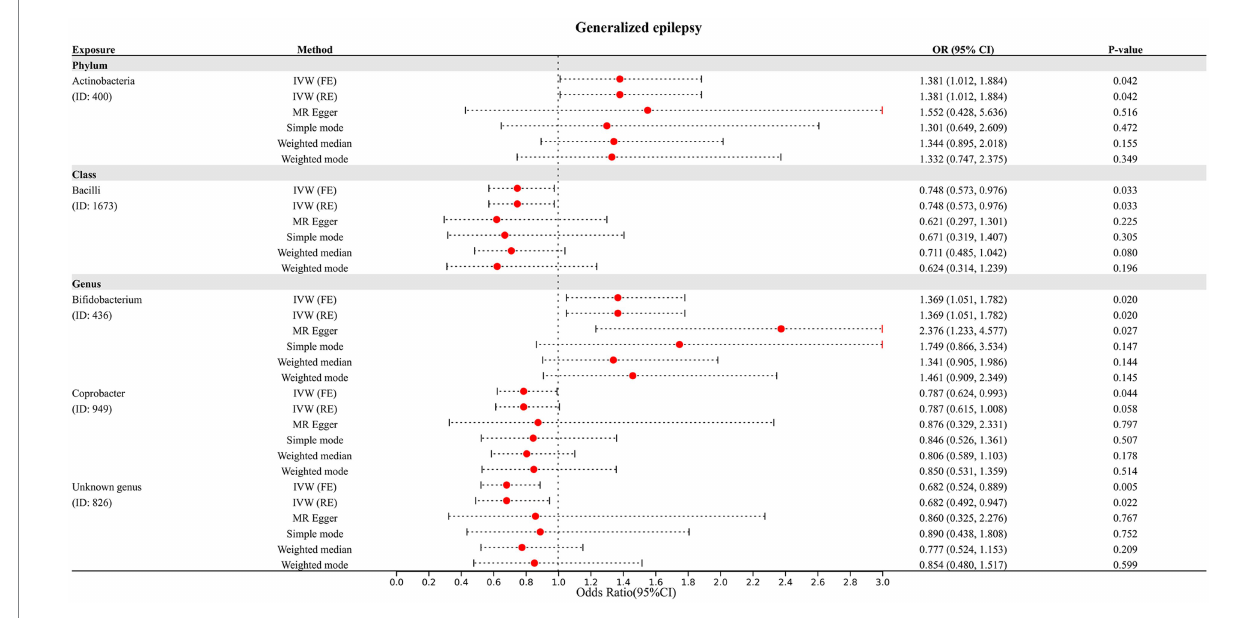
FIGURE 4 Diverse MR results for 5 GM taxa causally associated with generalized epilepsy.